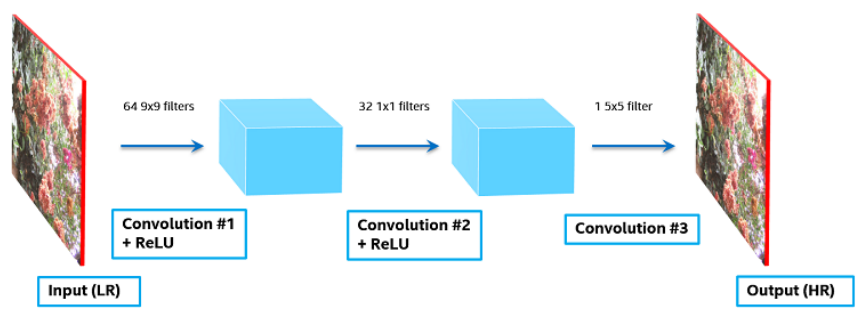
Figure 12. Deep learning-based super-resolution [9].